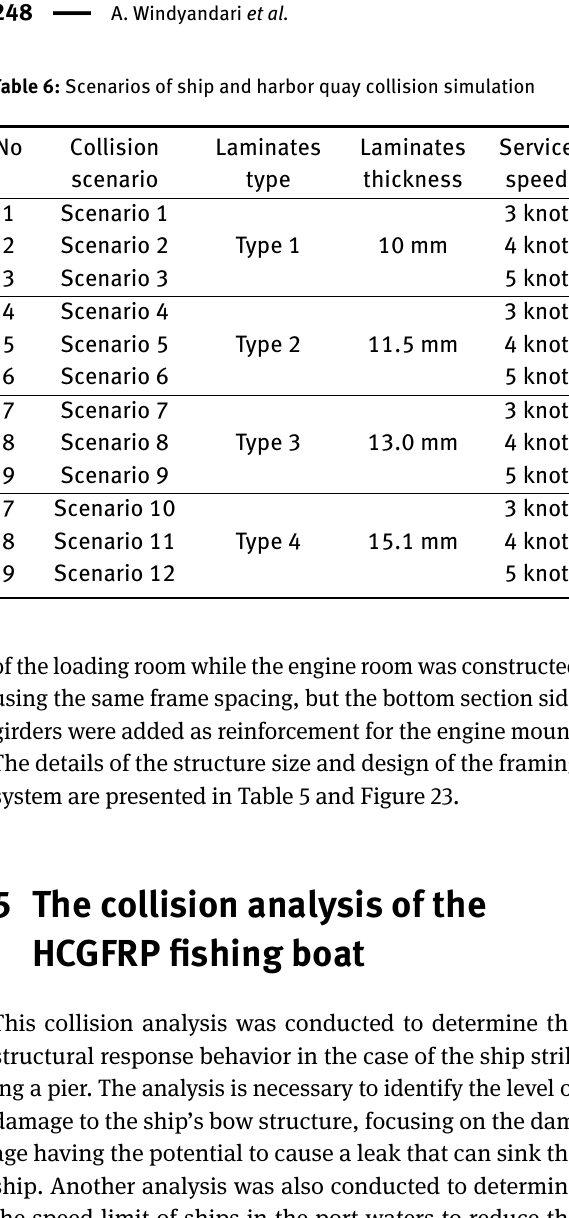
Figure 26: Force – displacement of each type of laminate based on